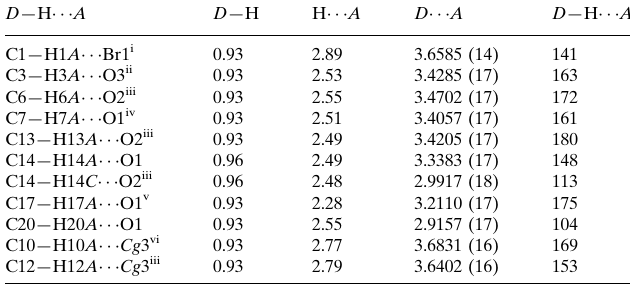
Hydrogen-bond geometry (A˚ , (cid:4)